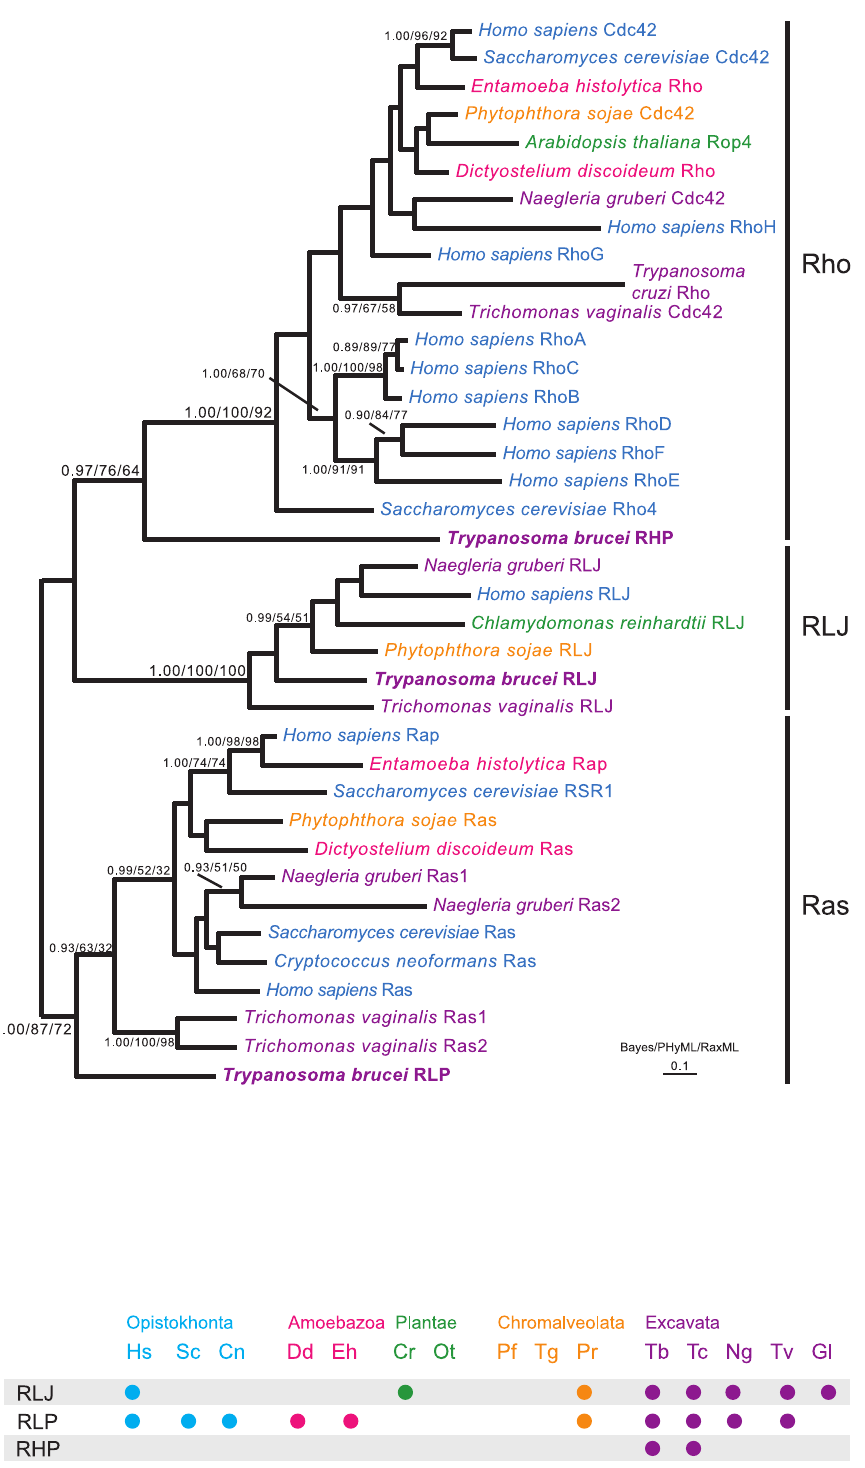
Figure 1. A novel Rho-related protein in trypanosomatids. (A) Bayesian reconstruction of Rho protein phylogeny. See methods for details. Numbers at internodes indicate statistical robustness and are for Baysian/PhyML/RaxML posterior probability, bootstrap and bootstrap support respectively. Clades are indicated by vertical bars and taxa colored according to supergroup membership: blue; Opisthokonta, pink; Amoebozoa, green; Viridiplantae, Orange; Chromalveolata and purple; Excavata. T. brucei sequences are highlighted in bold. (B) Comparative genomics representation of divergent Ras/Rho-related proteins across multiple taxa as determined by reciprocal BLAST and phylogenetic analysis. Taxa are colored as in (B) and two letter abbreviations are as in (B) plus Sc; S. cerevisiae , Cn; C. neoformans , Dd; D. discoideum , Eh; E. histolytica , Cr; C. reinhardtii , Ot; O. tauri , Pf; P. falciparum , Tg; T. gondii , Pr; P. ramorum , Tc; T. cruzi , Ng; N. gruberi , Tv; T. vaginalis and Gl; G. lamblia . RLP, RLJ and RHP denote Ras-like protein, Ras-like protein with DNAj domain and Rho-like protein respectively. Gray bars are for clarity. doi:10.1371/journal.pone.0026890.g001 PLoS ONE | www.plosone.org